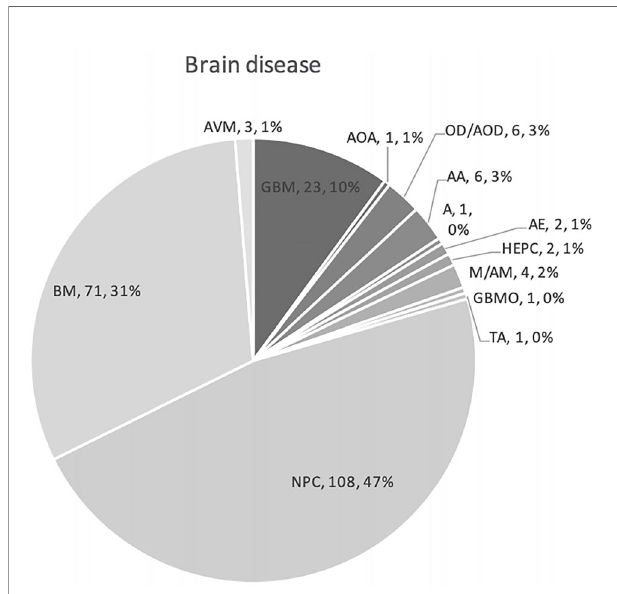
FIGURE 3 | Graph showing various primary pathologies and metastatic brain disease for which cranial radiation was used. Abbreviations used indicates as follows: NPC, nasopharyngeal carcinoma; BM, brain metastases; GBM, glioblastoma; A, astrocytoma; AOA, anaplastic oligoastrocytoma; OD, oligodendroglioma; AOD, anaplastic oligodendroglioma; AA, anaplastic astrocytoma; GBMO, glioblastoma multiforme with oligodendroglial component; A, astrocytoma; HEPC, hemangiopericytoma; AE, anaplastic ependymoma; M, meningioma; AM, anaplastic meningioma; TA, tectal astrocytoma; and AVM, arteriovenous